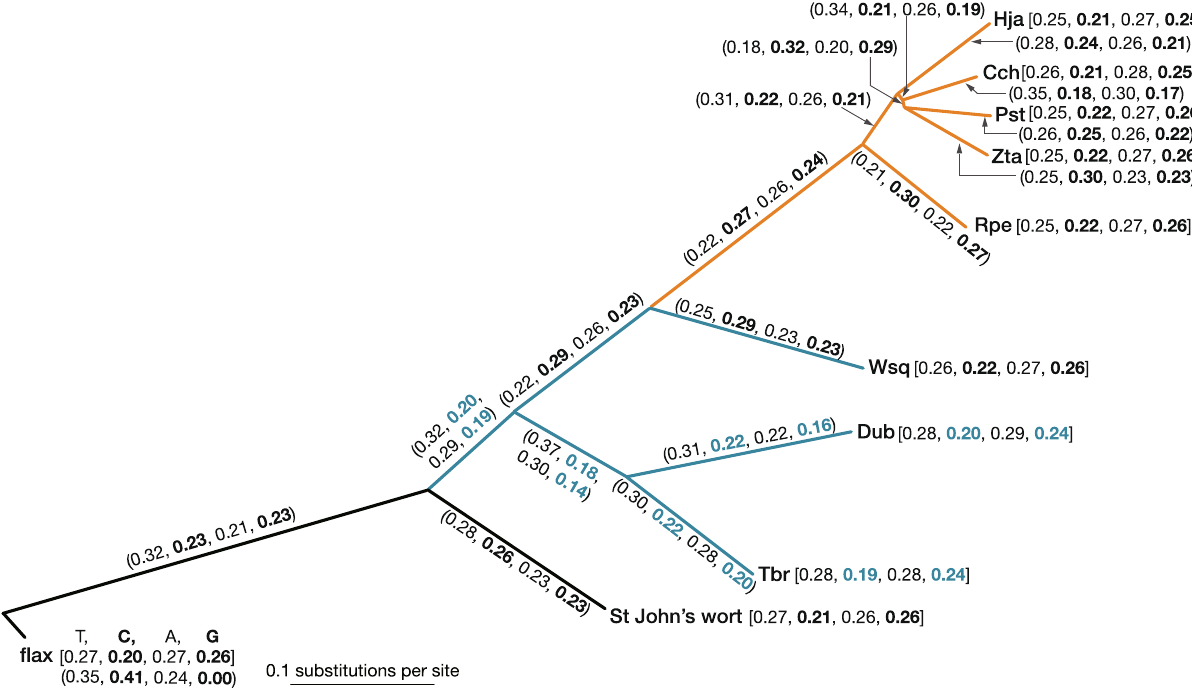
functions and are subject to natural selection, synonymous substitutions often have weak selective effects and are expected to behave as nearly neutral mutations 4,31 . Differences in the synonymous substitution rate ( d S ) are, therefore, mainly attribu- table to differences in the underlying mutation rate 32 . In the d S tree using concatenated sequences, there were long branches in the family Podostemaceae. On average, the substitution rates in the basal branches of Podostemaceae were 2.40 times greater than those of the outgroups, and the rates in the Podostemoideae branches were 1.70 times those of the basal subfamilies (Fig. 2).